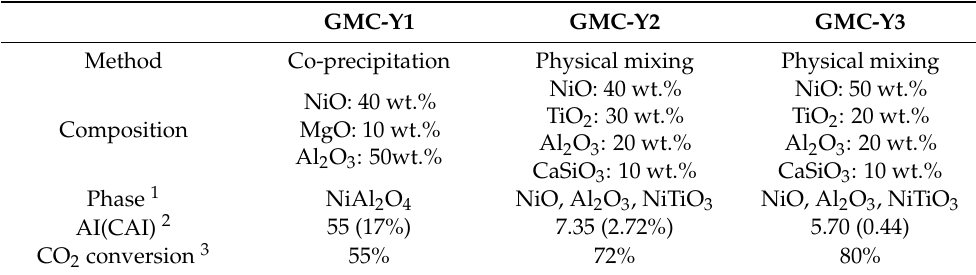
Table A1. Information of the GMC-Y1,2,3 catalysts.